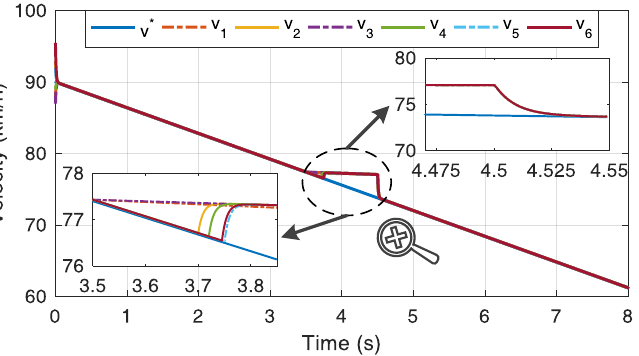
Figure 7. Velocity curve of each carriage with the proposed consensus braking controller in case